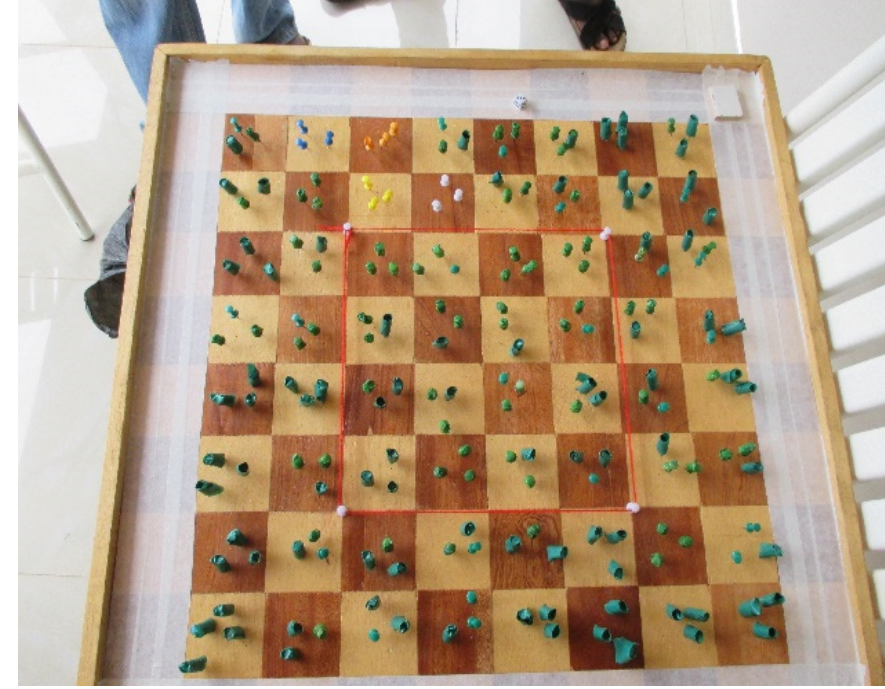
Figure 3. Game board for the role-playing game.